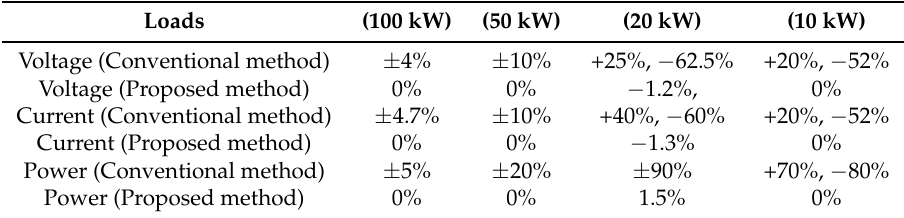
Table 2. Fluctuation ranges of the conventional